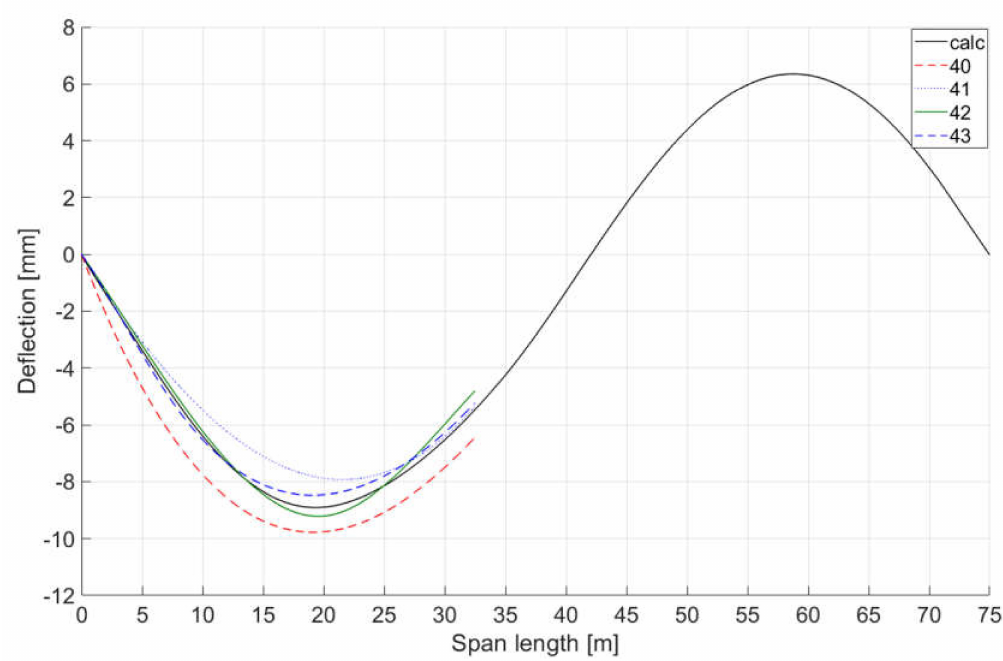
Figure 7. Analysis of the accuracy of the structure quasi-static deflection mapping using spline curves in relation to the deflection curve determined with the use of numerical model load data (calc); 40—deflection curve determined by a single 3 ◦ curve, 41—line determined by a single 3 ◦ curve with an angle of rotation at support equal to that of inclinometer I1, 42—line determined by 2 spline curves with an angle of rotation at support equal to that of inclinometer I1, 43—line determined by 3 spline curves with an angle of rotation at support equal to that of inclinometer I1.